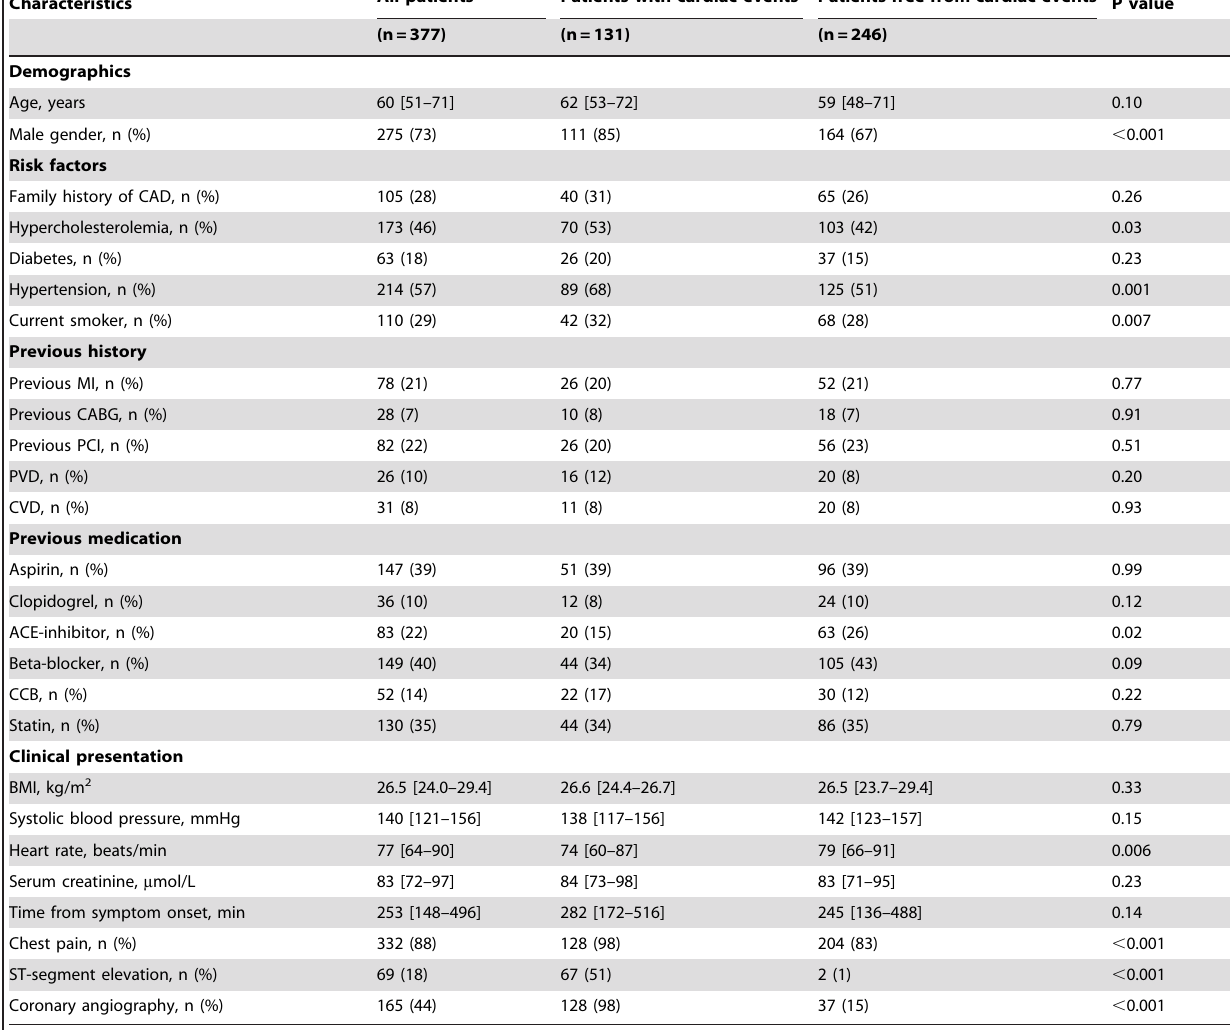
Table 1. Baseline characteristics.